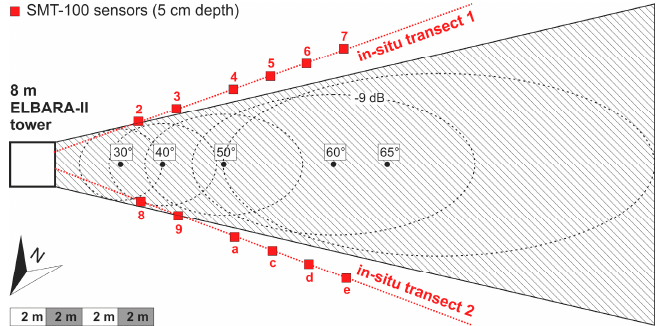
Figure 1. Diagram of the footprint areas and the location of the in-situ sensors. ETH L-band Radiometer-II (ELBARA-II) was mounted atop an 8-m tower indicated by the hollow black square.